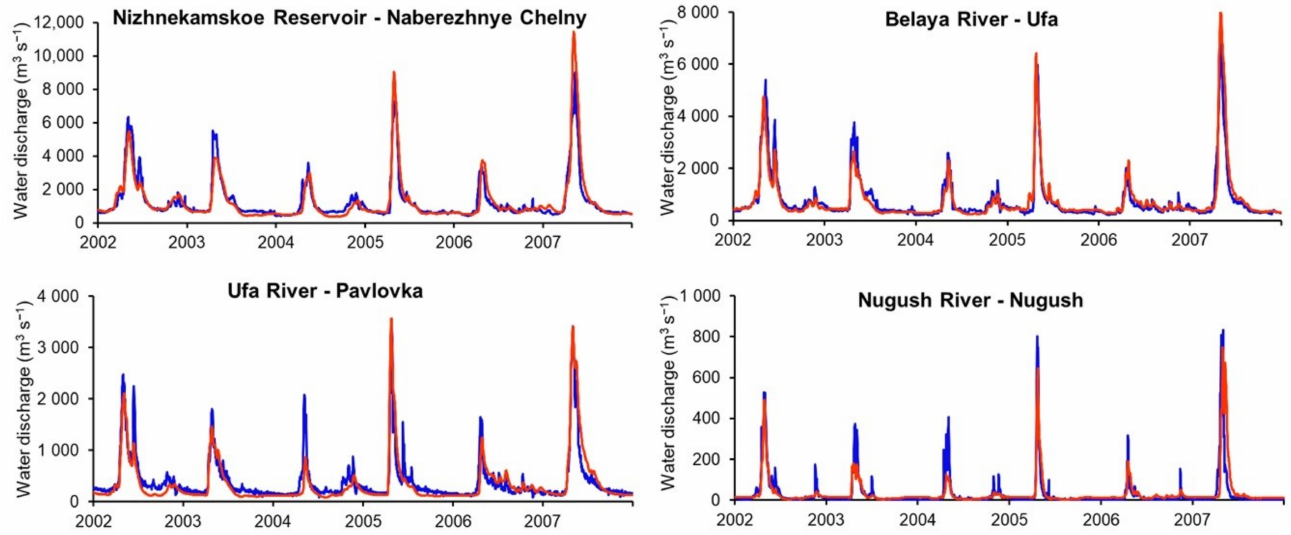
Figure 3. Observed (blue) and simulated (red) hydrographs of the Belaya River and inflow into